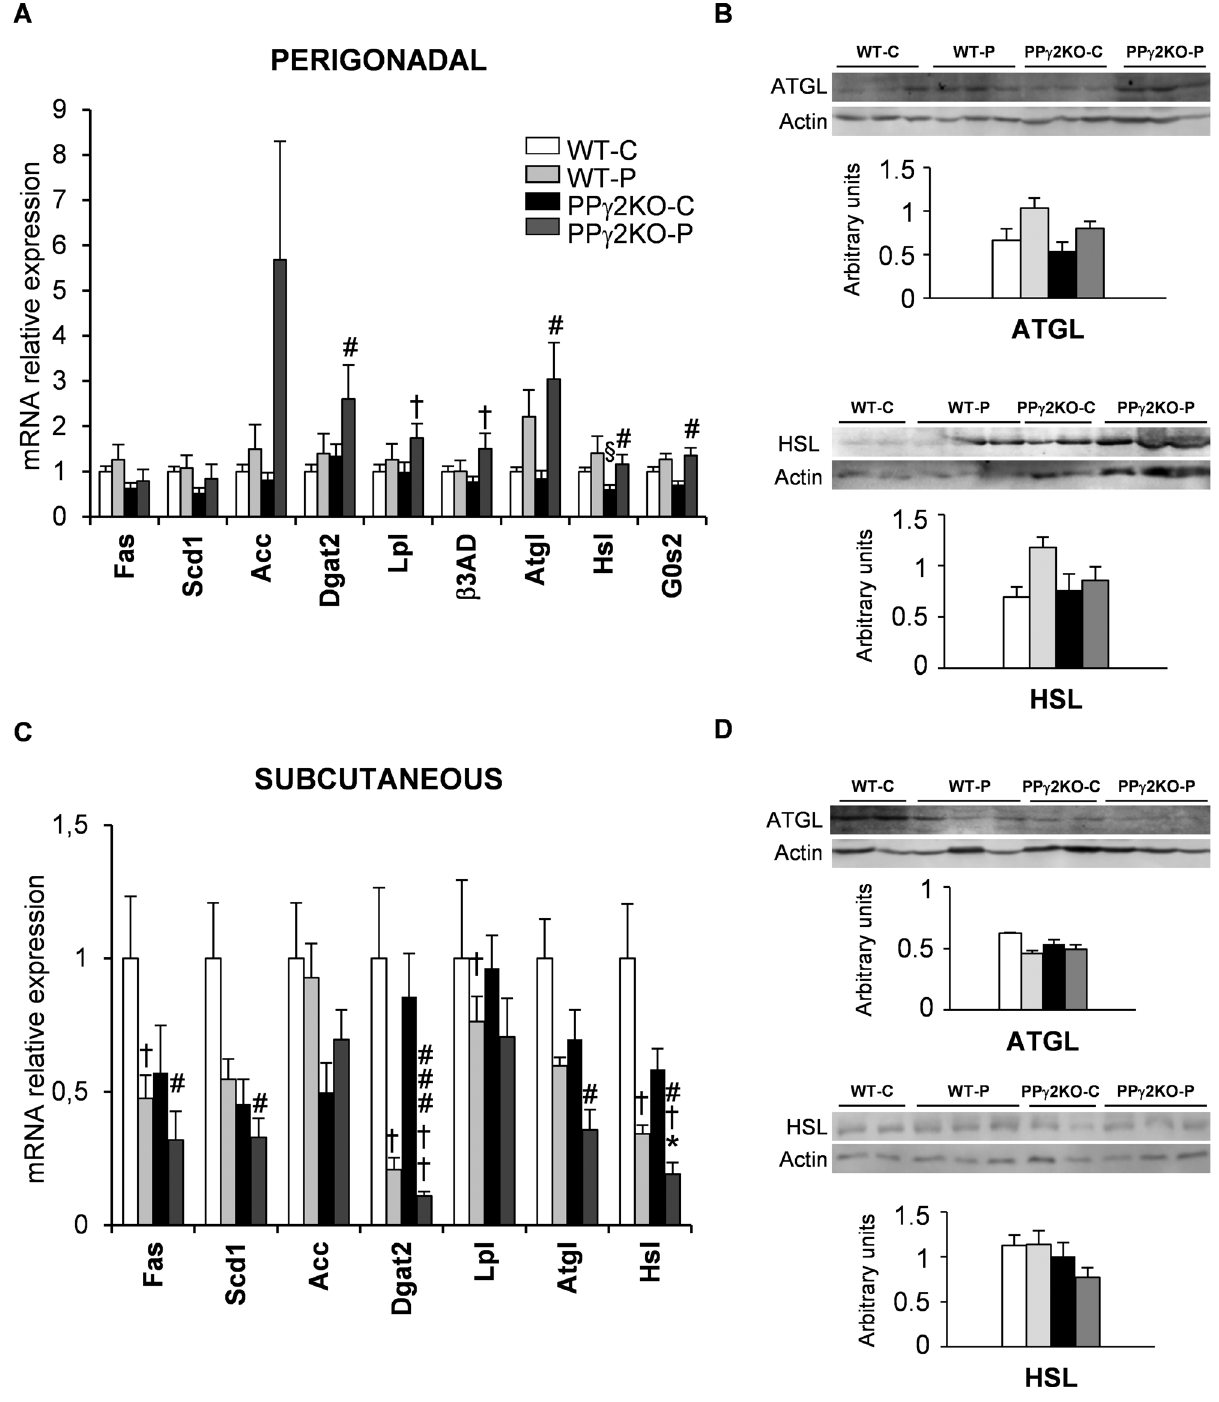
Figure 3. Role of PPAR γ 2 in fat storage and mobilization in perigonadal and subcutaneous WAT depots during pregnancy. (A and C) mRNA levels of lipogenic and lipolytic genes in (A) perigonadal and (C) subcutaneous fat depots from pregnant and nonpregnant WT and PP γ 2KO mice. Data are expressed as mean ± SEM (n = 6–8 animals/group). Total protein quantification of lipolytic enzymes ATGL and HSL in homogenates from (B) perigonadal and (D) subcutaneous fat depots from pregnant and nonpregnant WT and PP γ 2KO mice. Levels of protein were normalized to total β -actin. Data are expressed as mean ± SEM (n = 3–5 animals/group). * p ≤ .05 PP γ 2KO-P versus WT-P; # p ≤ .05; ### p ≤ .001 PP γ 2KO-P versus WT-C; † p ≤ .05; †† p ≤ .01 pregnant versus non pregnant; § p ≤ .05 PP γ 2KO-C versus